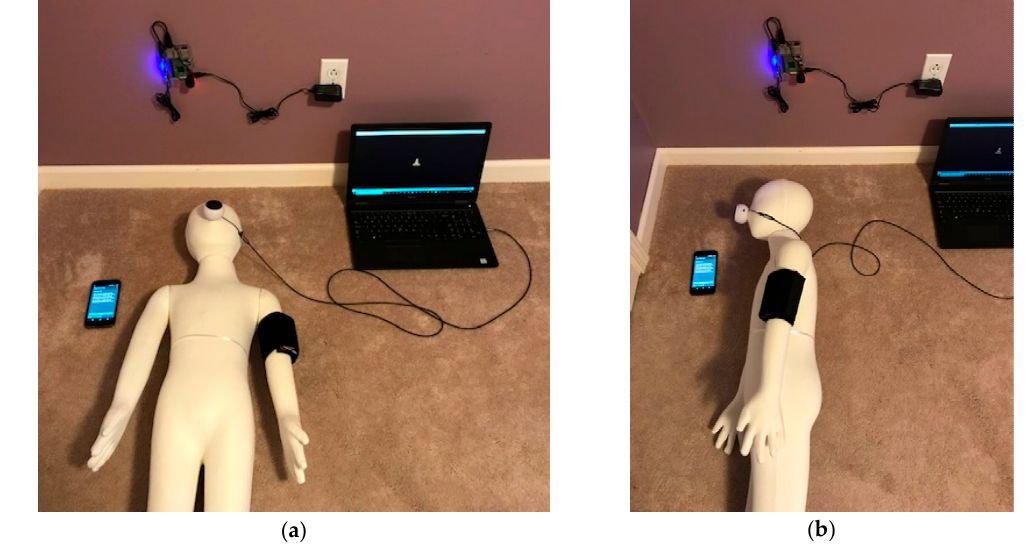
Figure 13. Photograph of the experimental setup. ( a ) The wearable gadget generates vibration when the listener module detects snoring and the mannequin is sleeping on the back. ( b ) Vibration stops when the mannequin’s sleeping position is changed to the side.